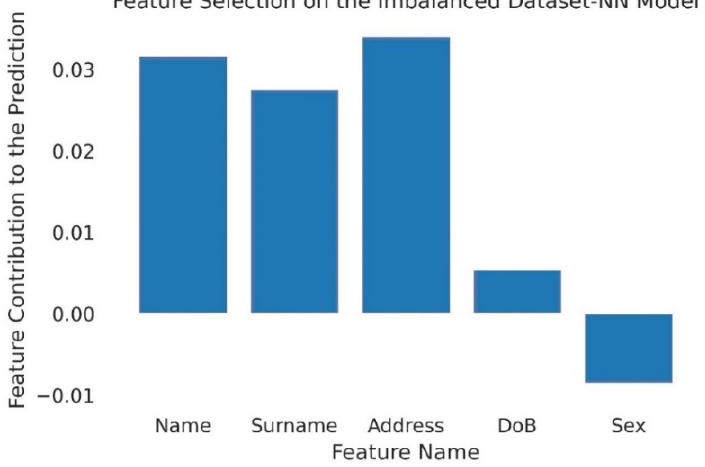
Figure 3. Feature importance of the LR model using the imbalanced dataset as input.